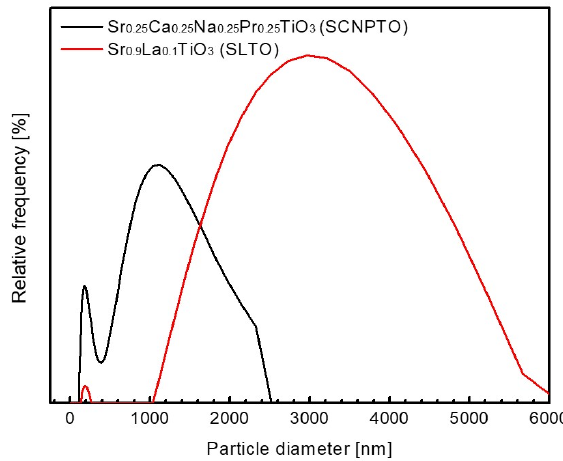
Figure 3. Particle size distribution of investigated materials.